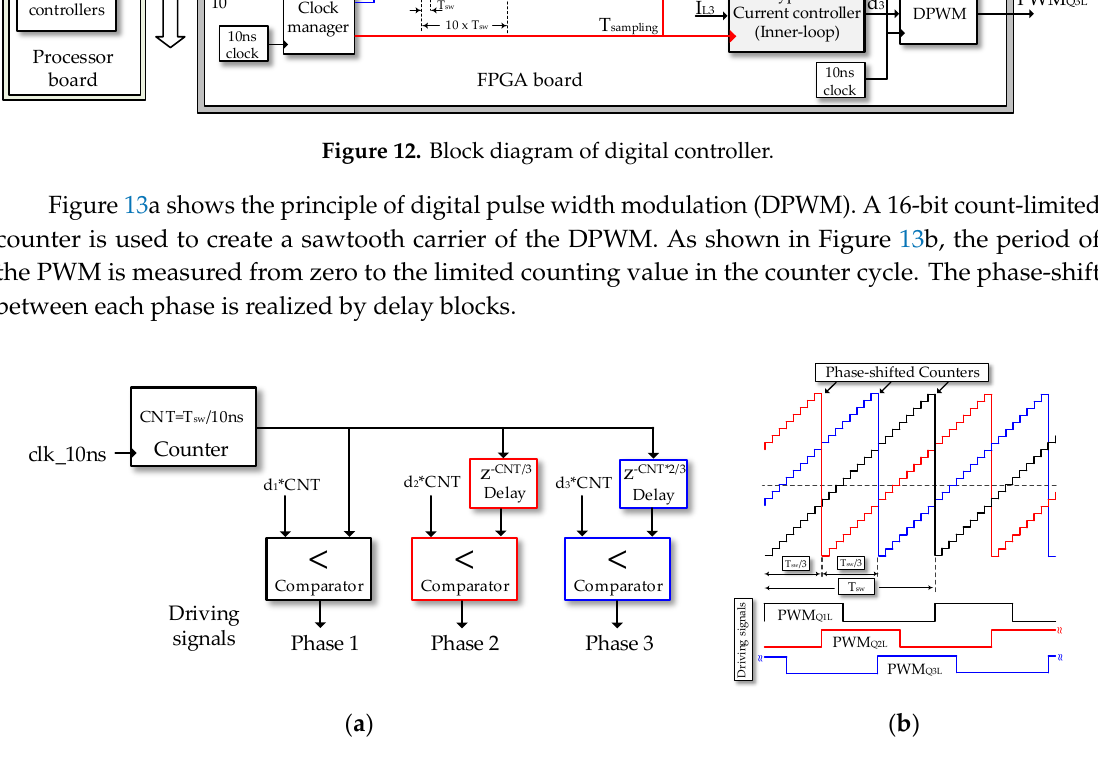
Figure 13. ( a ) Block diagram of digital PWM generator, ( b ) simplified phase-shifted operation for PWM driving signals.